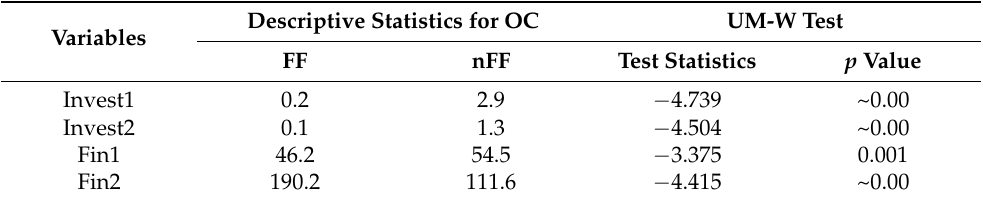
Table 3. Descriptive statistics describing investment and financing strategy in subsamples for overconfident CEOs.